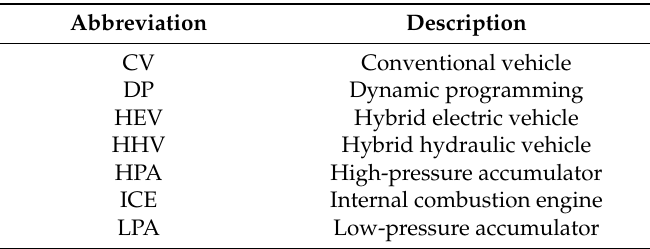
Table A2. List of abbreviations.